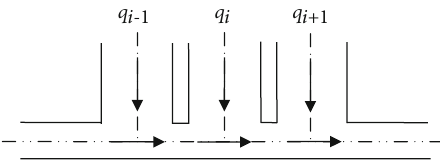
Figure 1: Diagram of wellbore-reservoir coupling variable mass fl